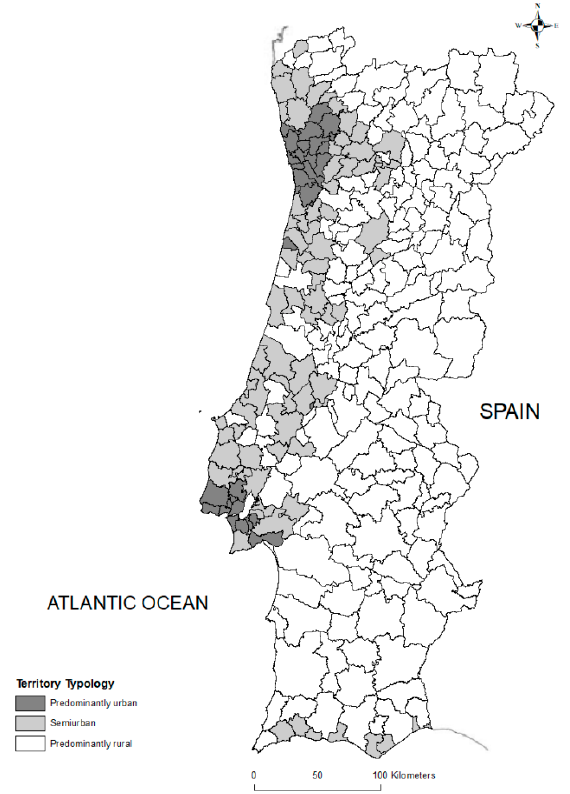
Figure 1. Classification of Portuguese municipalities by population density according to National Statistics Institute (INE) [35] .